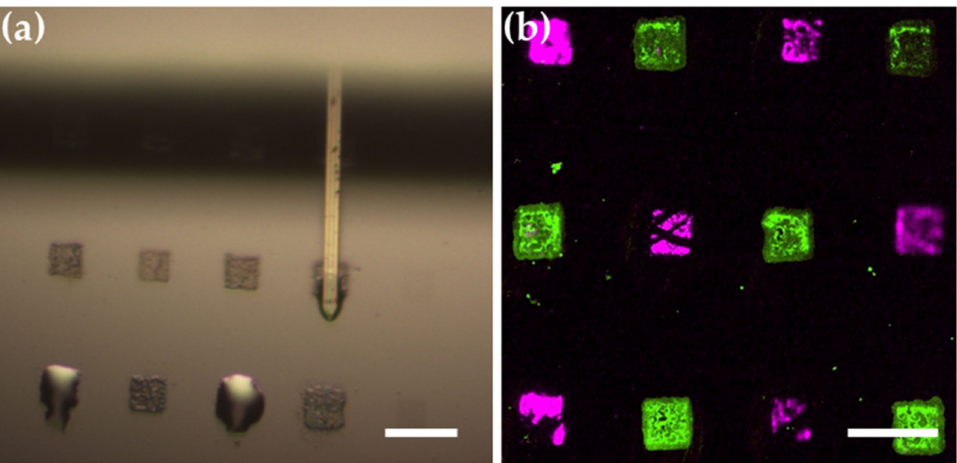
Figure 5. Multiplexing immobilization of antibodies on a lipid membrane patch array. ( a ) The optical microscopy image shows good stability and in situ visibility of the lipid membrane patches on the block-type MPC copolymer surface allows for easy addressing and directly spotting of antibodies with the µ CS probe. Two membrane stacks in the lower visible array row are already covered with the incubation droplet. ( b ) The fluorescence microscopy image shows subsequent immuno-staining with secondary antibodies and reveals the successful multiplexed immobilization of EpCAM antibody (green) and Annexin A1 antibody (purple). Scale bars equal 20 µ